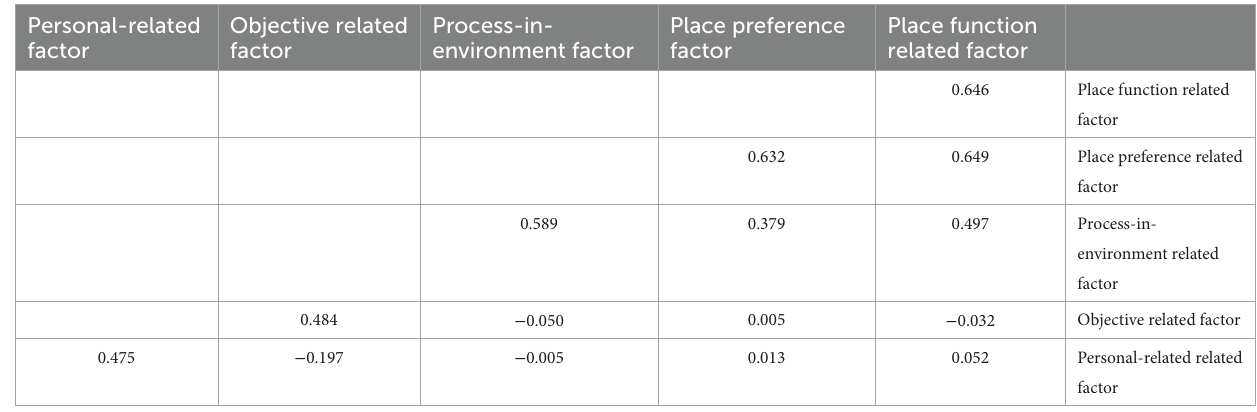
TABLE 3 Fornell–Larcker criterion